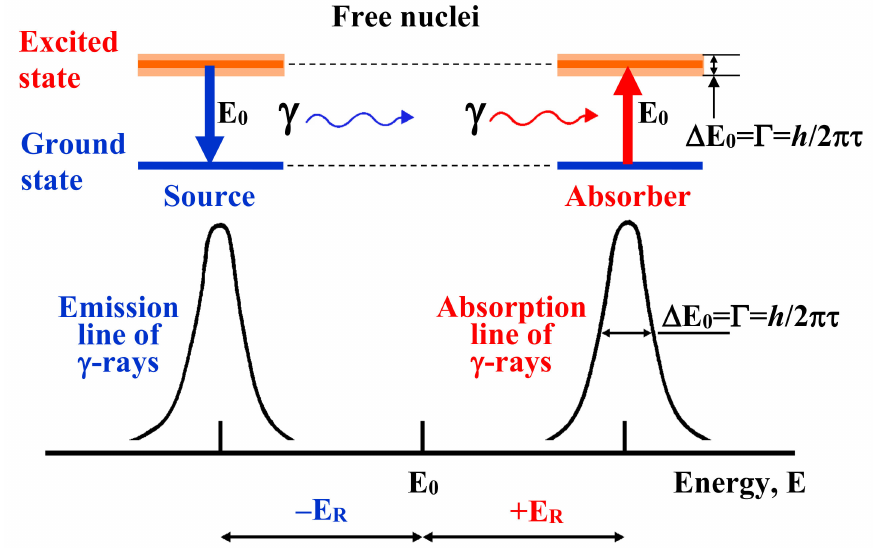
Figure A1. Diagram of the energy levels and nuclei transitions in the source and absorber and energy spectra of γ -rays emission and absorption by free nuclei. The absence of the resonance emission and absorption of γ -rays is due to recoil energy loss in the case of free